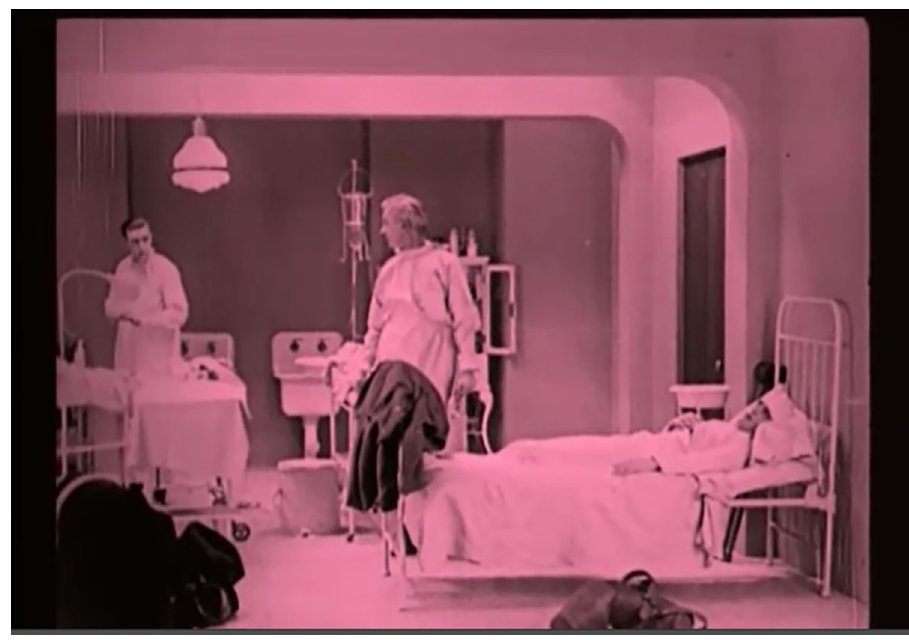
Fig 1. The Penalty (1920). The villain after the successful neurosurgical